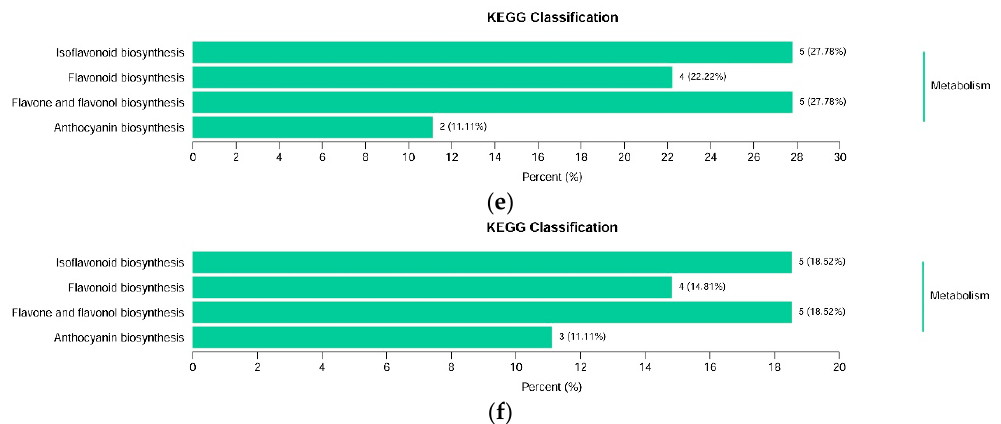
Figure 5. Venn diagram of differential flavonoid metabolites for each comparison group and Kyoto Encyclopedia of Genes and Genomes (KEGG) classification results. ( a ) Venn diagram shows the overlapping and unique differential metabolites amongst the comparison groups; ( b ) Venn diagram shows the overlapping and unique metabolites amongst the comparison groups; ( c )–( f ) The differential metabolites KEGG classification of the comparison group DHP versus BZH, DHP versus HZY, DHP versus TC, and DHP versus YCC, respectively. Table 1. A list of biologically active down-regulated flavonoid metabolites detected in “Dahongpao” (DHP).